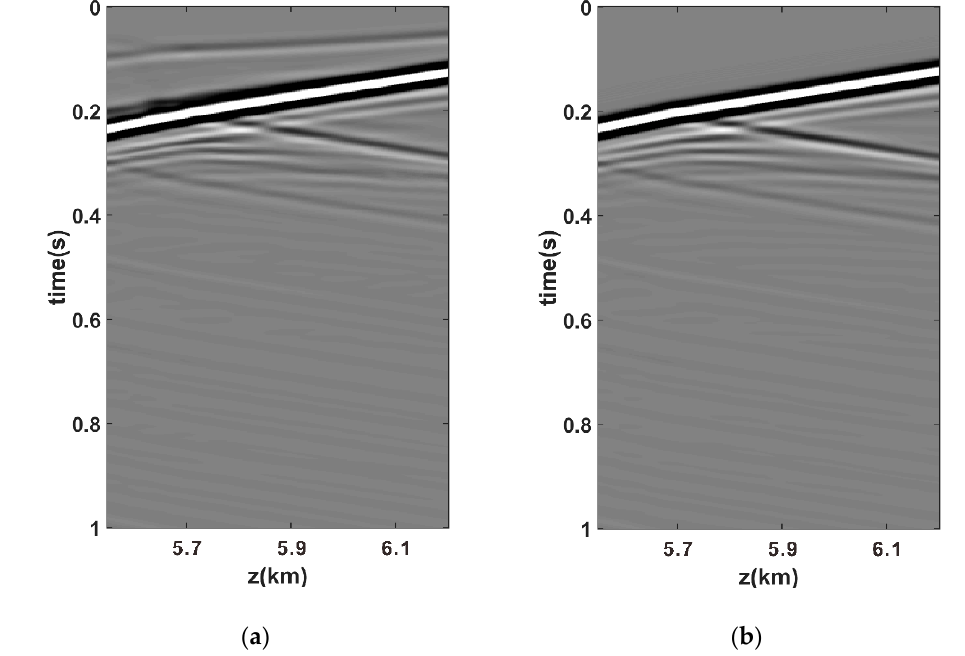
Figure 9. The common source gathers with a column of virtual receivers x vr = (X: 2155 m, Z: 5555–6185 m) corresponding to a virtual source at x vsp = (X: 2500 m, Z: 6600 m) from ( a ) the Marchenko source-receiver redatuming with VSP data retrieved wavefield and ( b ) wavefield obtained by waveform modeling.